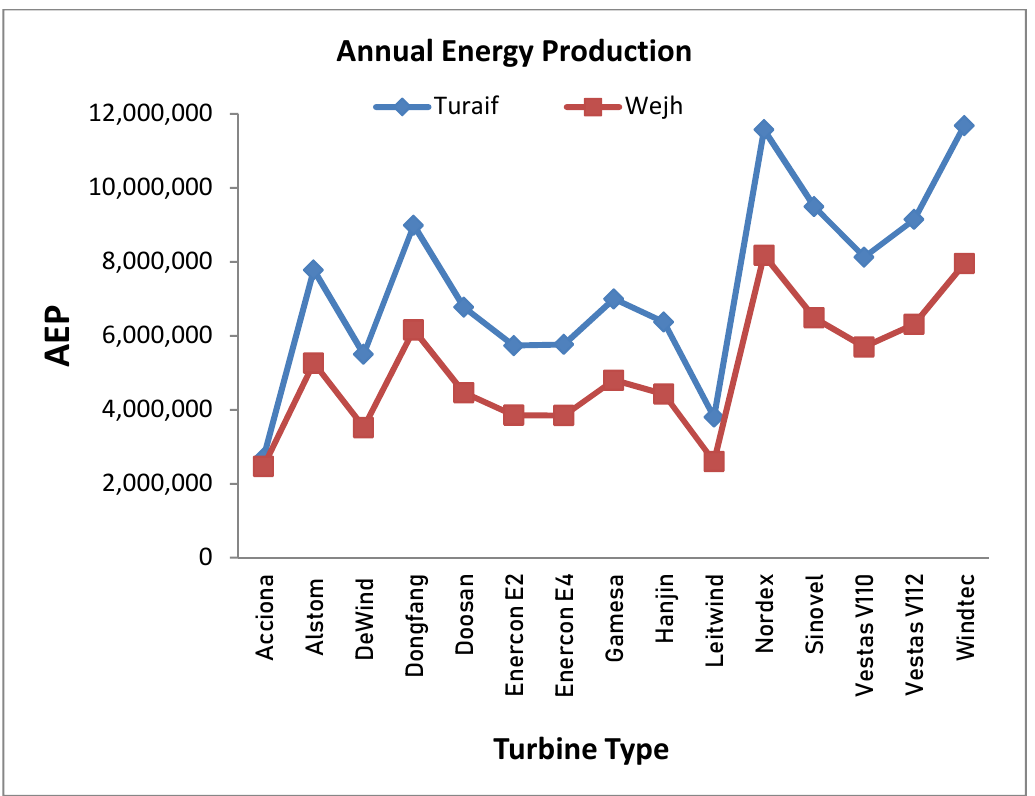
Figure 3. Comparison of annual energy production (AEP) for different turbines for Turaif and Wejh.